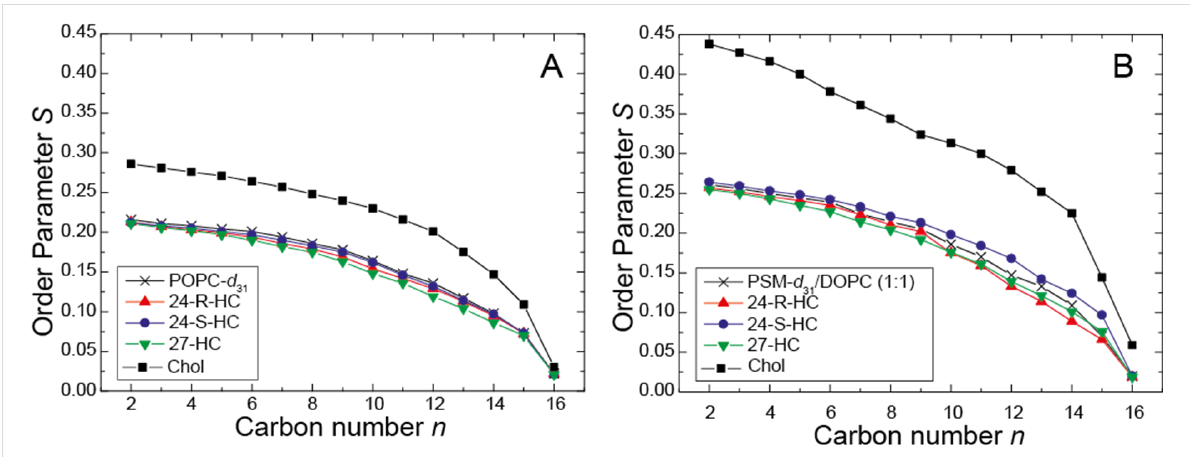
Figure 2: 2 H NMR chain order parameter of the sn -1 chain of (A) POPC- d 31 in the absence and in the presence of the respective sterol (molar ratio 0.8:0.2) and (B) PSM- d 31 in PSM- d 31 /DOPC/sterol membranes (molar ratio 1:1:1), (24 R )-hydroxycholesterol (red), (24 S )-hydroxycholesterol (blue) and 27-hydroxycholesterol (green) at a temperature of 30 °C. For comparison, the chain order parameters of a lipid membrane without any sterol and in the presence of the respective amount of cholesterol are shown in black [18]. Experimental errors are smaller than the symbol size.